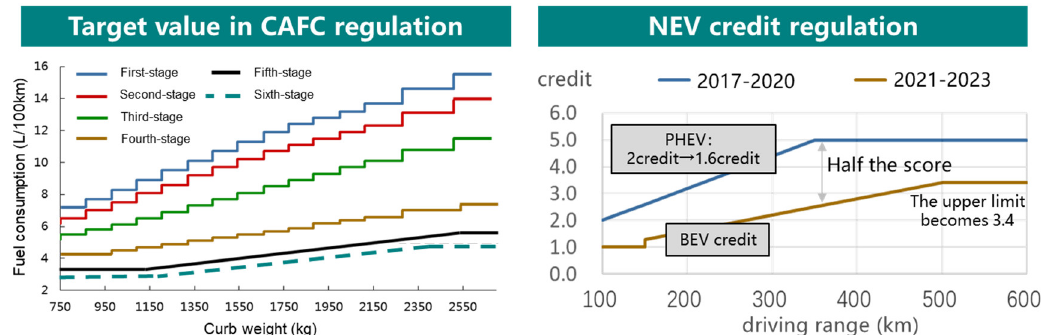
Figure 1. Target value in CAFC (Corporate Average Fuel Consumption) regulation and the NEV New Energy Vehicle) credit regulation. PHEV: plug-in hybrid vehicle; BEV: battery electric vehicle.